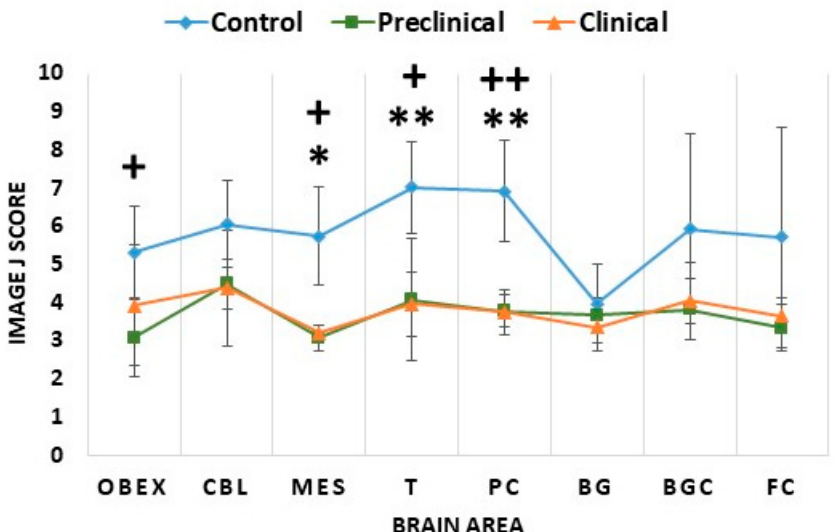
Figure 8. Comparison of 5mC Image J scores in the three sheep groups: control, preclinical, and clinical. The analyzed brain areas were the obex, cerebellum (CBL), mesencephalon (MES), thalamus (T), parietal cortex (PC), basal ganglia (BG), basal ganglia cortex (BGC), and frontal cortex (FC). The data are presented as mean values ± SEM. * Significant difference between control and clinical sheep ( p < 0.05); ** significant difference between control and clinical sheep ( p < 0.01); + significant difference between control and preclinical sheep ( p < 0.05); ++ significant difference between control and preclinical sheep ( p < 0.01).